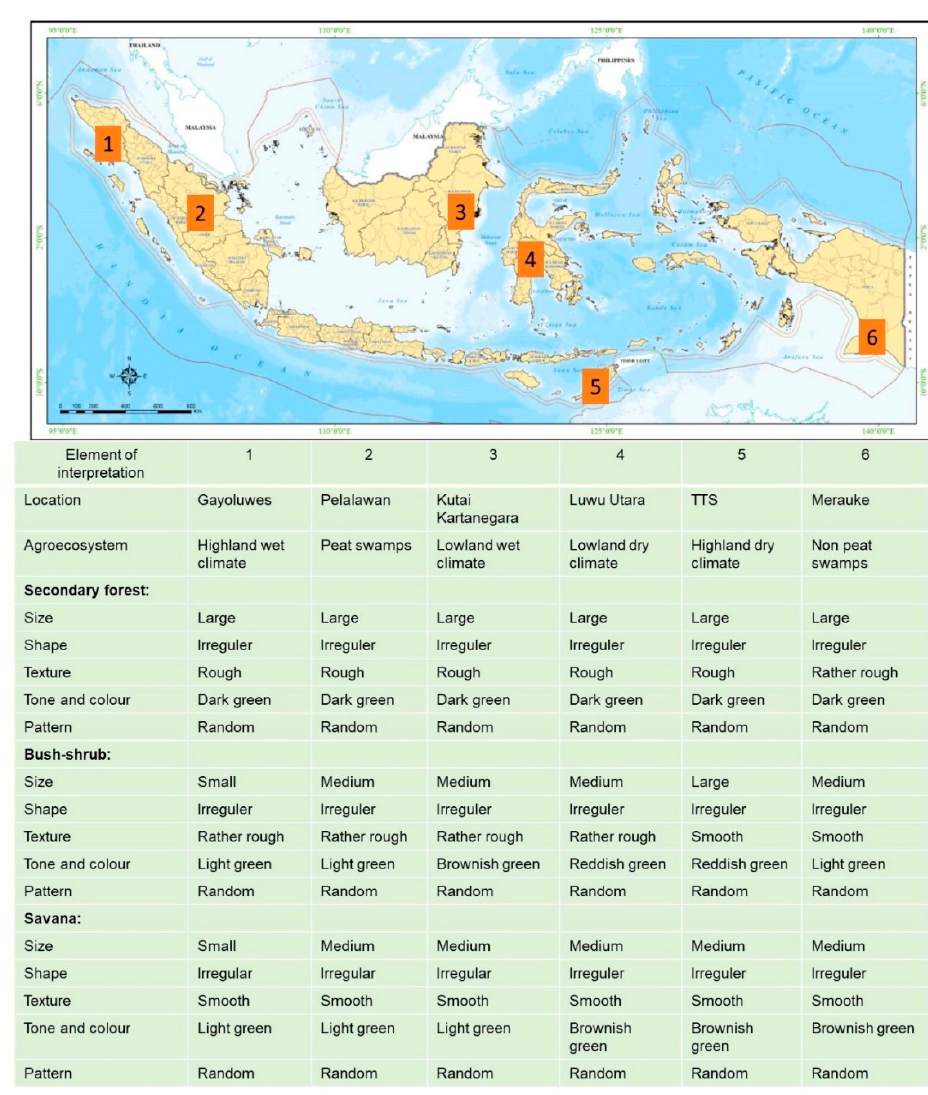
Figure 4. The characteristics of elements for the visual interpretation of AL (secondary forest, shrubs, and grasslands) in representative